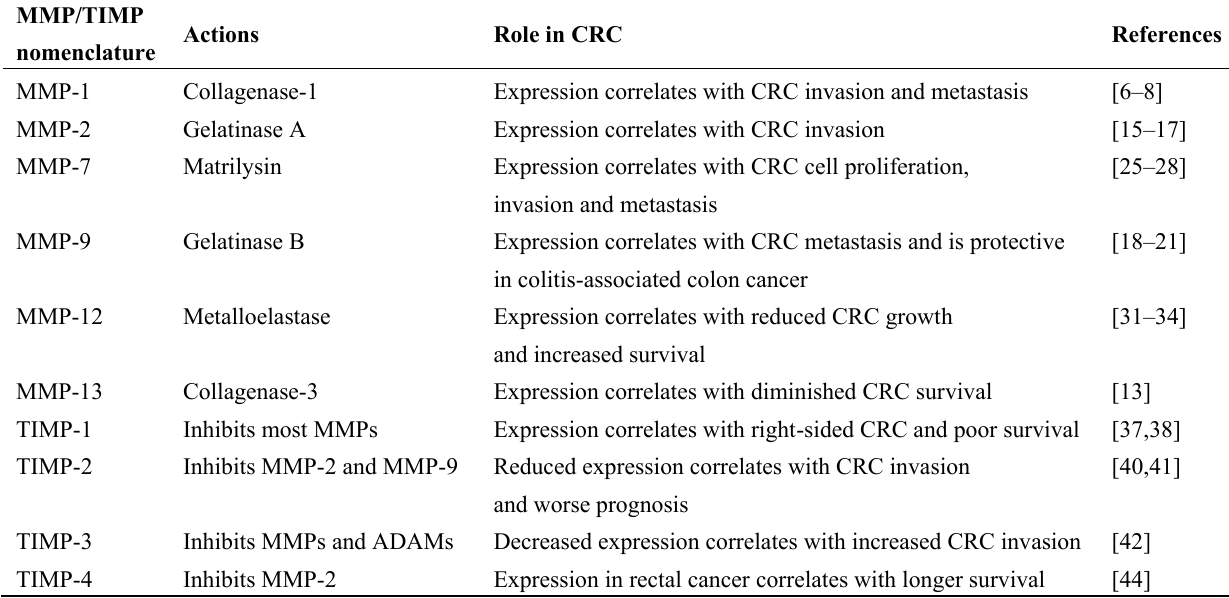
Table 1. Prominent MMPs and TIMPs in colorectal cancer